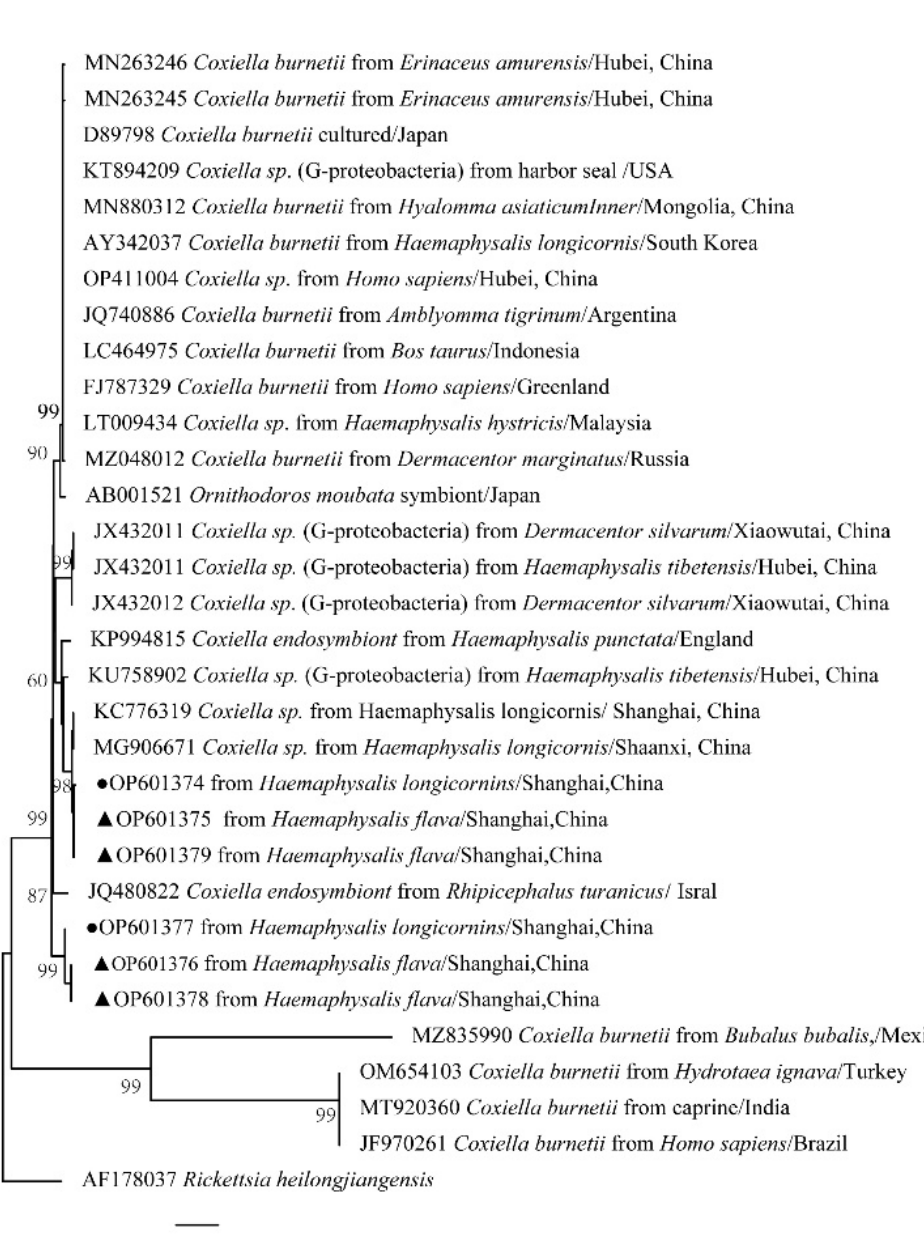
Figure 11. Phylogenetic tree of Coxiella spp. in ticks based on partial 16S rDNA gene sequence similarity. The sequence from H. flava obtained in this study is indicated with a black triangle, and the sequence from H. longicornis obtained in this study is indicated with black dots. Sequences were aligned using the MEGA X (version 10.0) software package. Phylogenetic analysis was performed by the neighbor-joining method (NJ method), and bootstrap values were estimated for 1000 replicates. The Kimura two-parameter model was used as a substitution model for the calculation of the phylogenetic